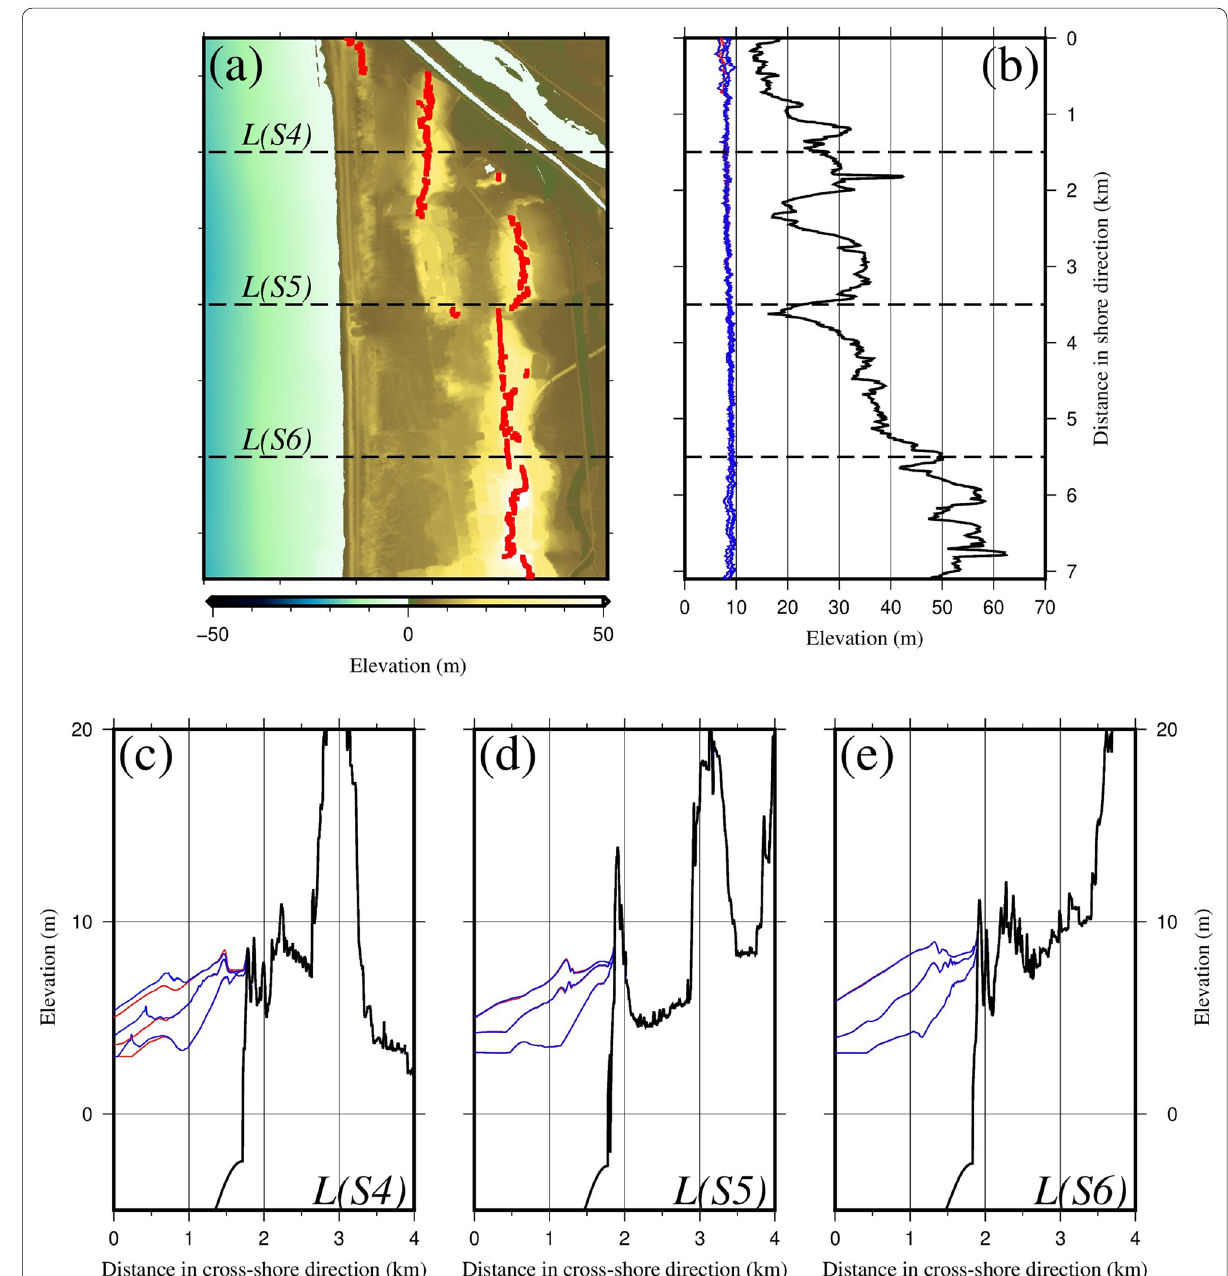
Fig. 5 Tsunami characteristics over the Shonai dune. a Geometry and cross-sectional slices within the gray area specified in the middle-right panel of Fig. 3, red circles indicate the highest locations along the cross-shore direction, and the thick interval was 1 km; b alongshore variations in the maximum run-up heights and the top elevation over the dune; c – e profiles of the dune and the maximum water surface elevation (inundation height) along the cross-sectional slices. Each line color in ( b – e ) indicates the dune profile (black) and the tsunamis in the F28, F30, and F34 source scenarios with the breakwaters (blue) and without